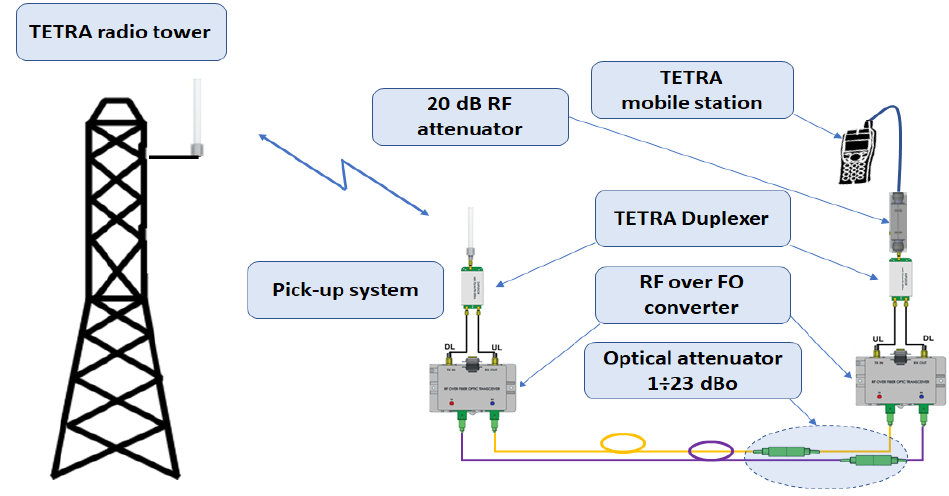
Figure 7. Testbed for determination of RF over OF converter sensitivity threshold.